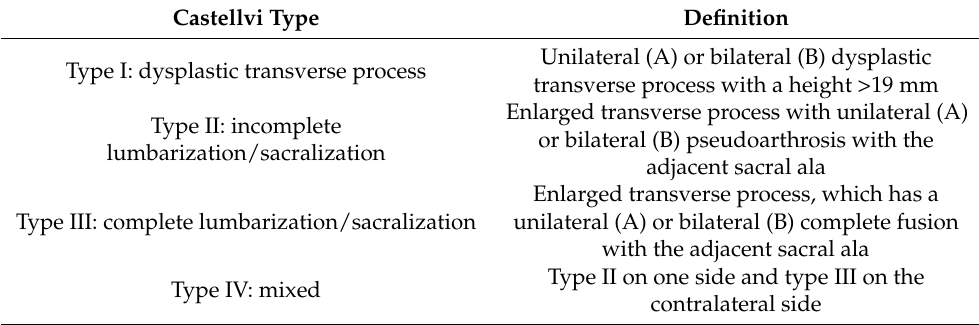
Table 1. Radiographic lumbosacral transitional vertebrae (LSTV) classification according to Castellvi